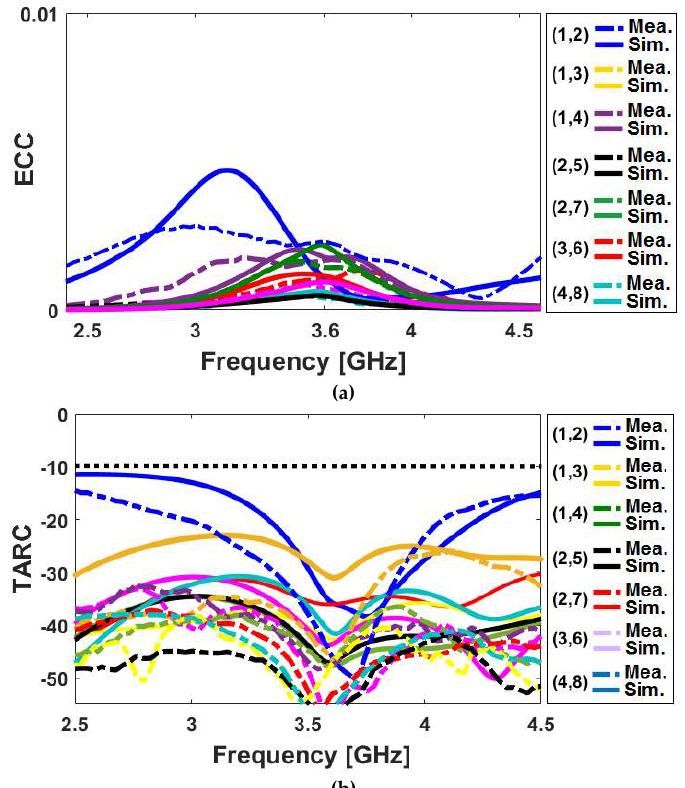
Figure 17. Calculated ( a ) envelope correlation coefficient (ECC) and ( b ) total active reflection coefficient (TARC) from measured S parameters.